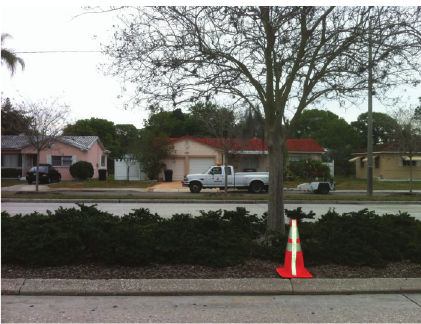
Figure 14: Starting point for the Tyrone Boulevard testing in St.